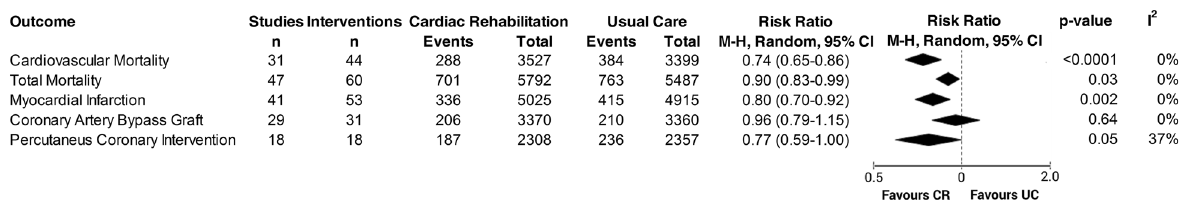
Fig. 4 The effect of exercise-based cardiac rehabilitation versus usual care on coronary heart disease outcomes. Diamonds represent the pooled summary estimate of random effects Mantel-Haenszel meta-analysis for each outcome. CR cardiac rehabilitation, UC usual care